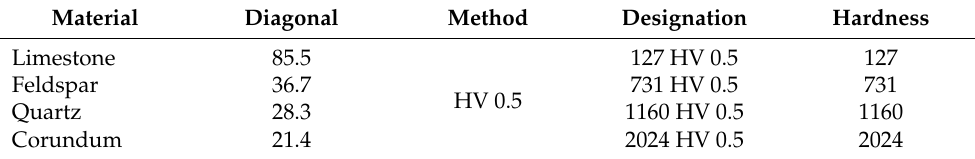
Table 7. Vickers hardness of materials.